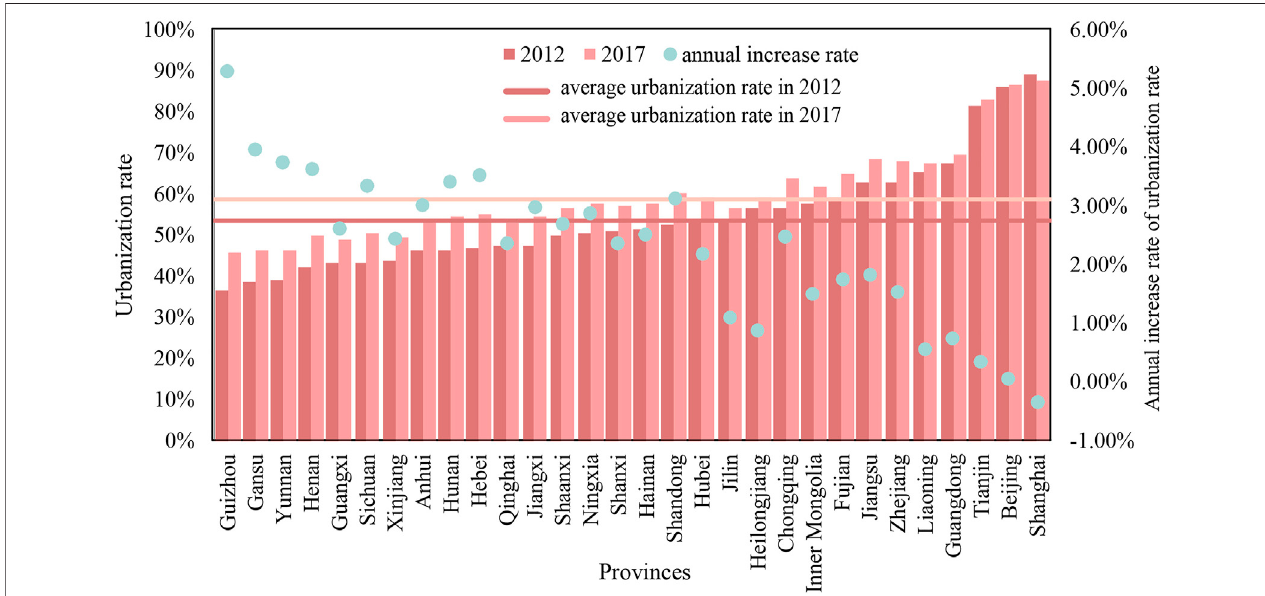
FIGURE 2 | The changes in urbanization rates among provinces from 2012 to